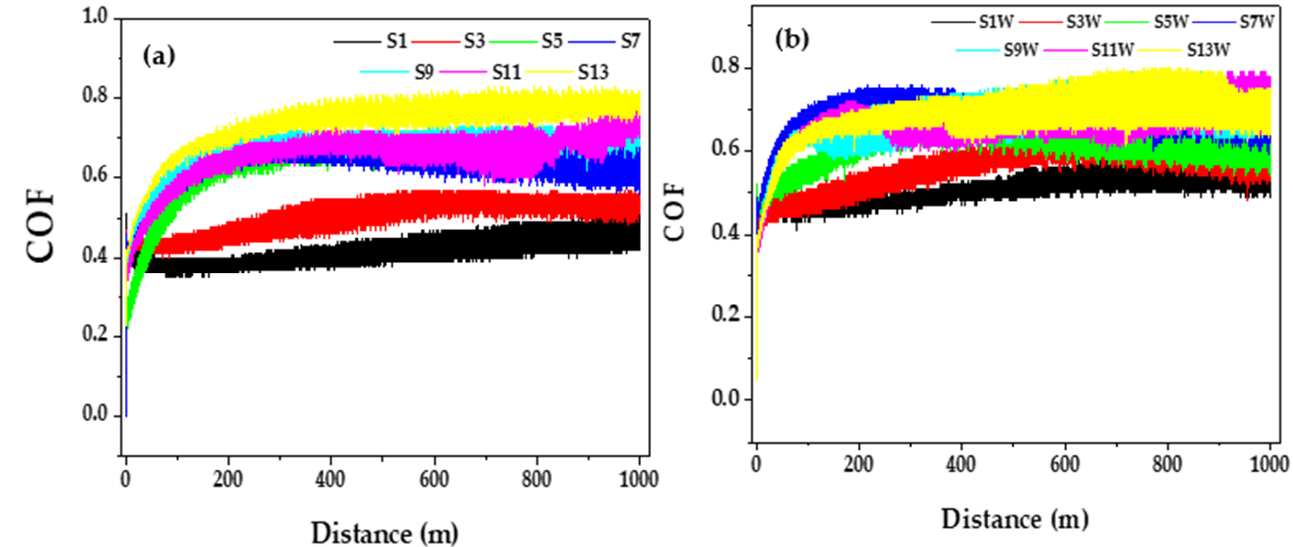
Figure 14. The coefficients of friction (COF)-sliding distance curves for ( a ) without and ( b ) with Na 2 WO 4 under 5 normal loads.